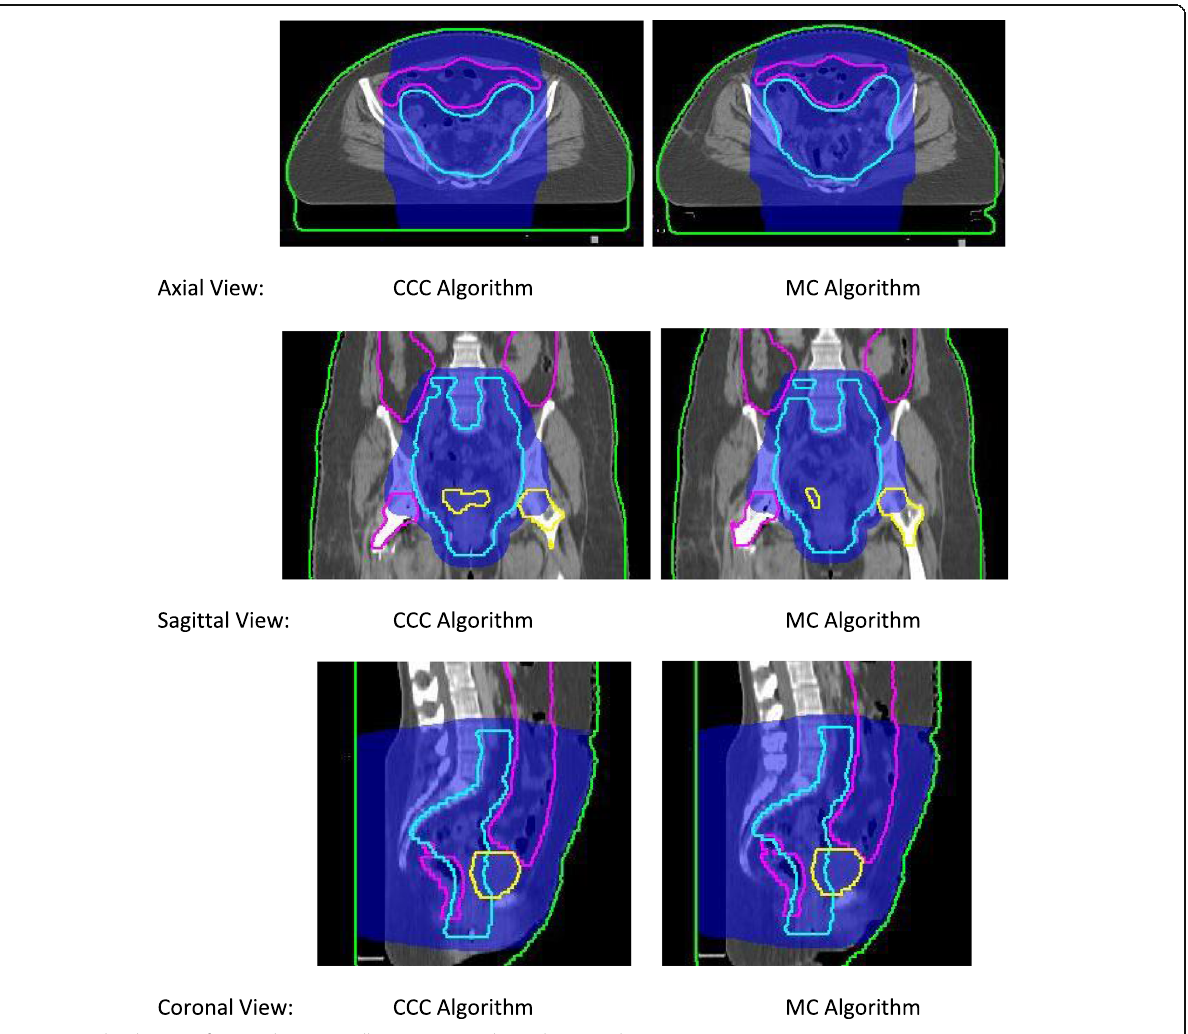
Fig. 5 Dose distribution of 20 Gy showing spillage to RFH and prosthesis